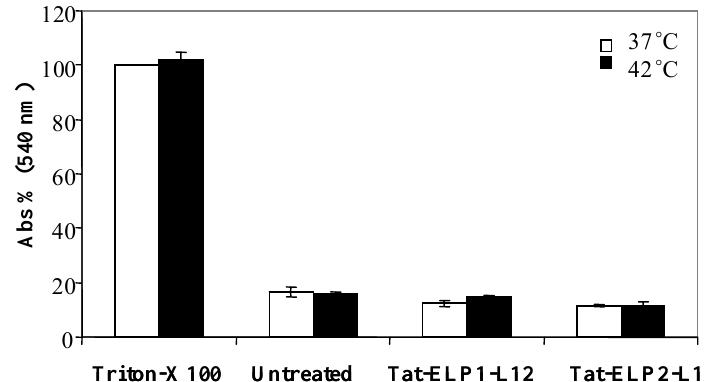
Figure 6. Hemolytic activity of